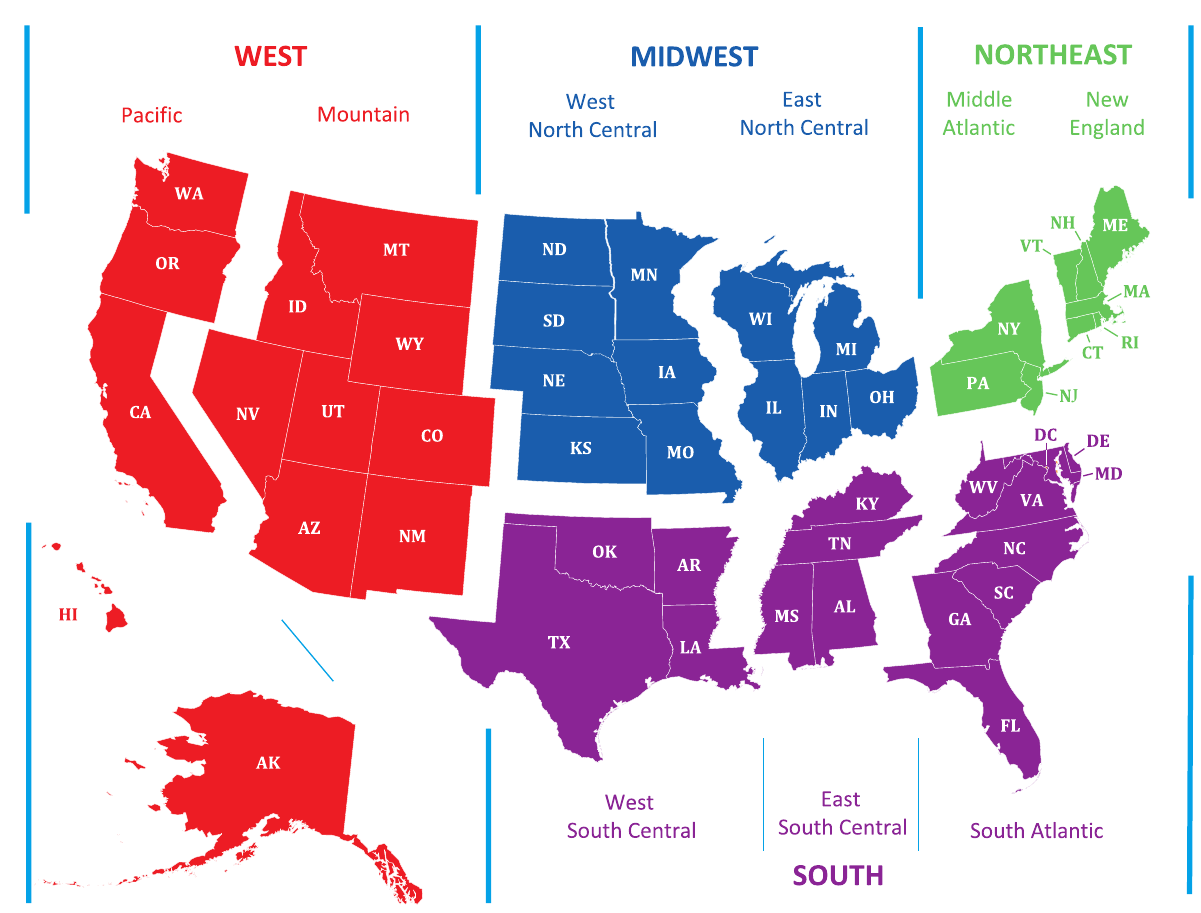
Figure 7. U.S. Census regions and